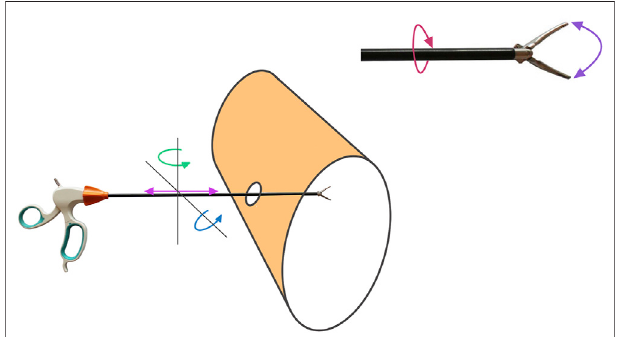
FIGURE 3 | Actuated DOF per laparoscopic instrument.